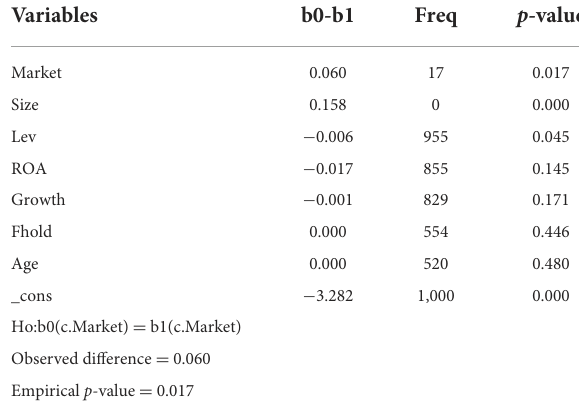
TABLE 6 Testing moderating effect by groups. TABLE 7 Fisher combination test